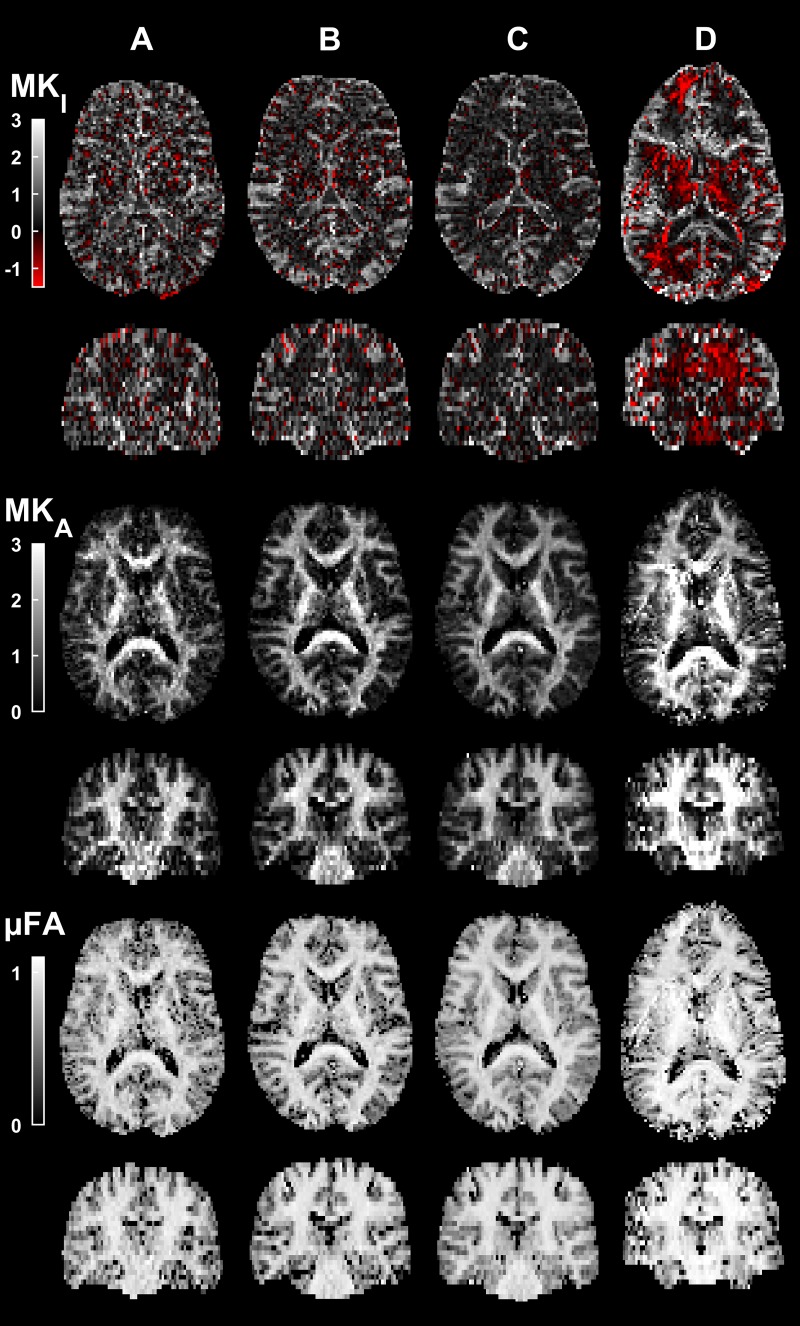
DIVIDE parameter maps in transversal and coronal slices for configurations A-D. The image quality generally improves with higher field strength and gradient amplitude. Most notably there is a discernably higher level of noise for configuration A. Configuration D generally exhibited higher MKA, a pronounced geometrical distortion at the anterior part of the brain, and more pronounced ghosting artifacts, as compared with the other configurations. Furthermore, large regions of negative MKI were observed only for configuration D.